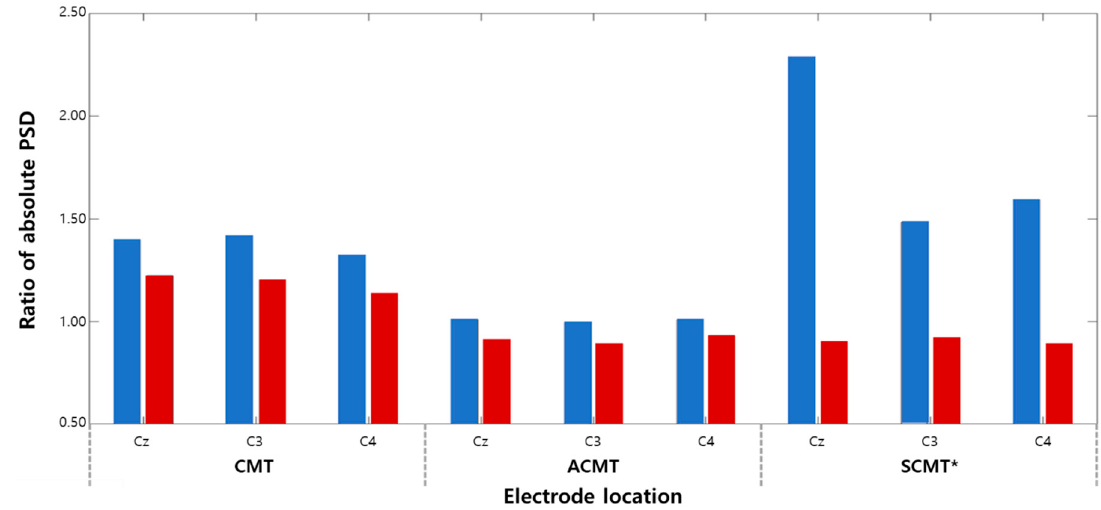
Figure 8. Absolute power spectral density (PSD) of the mu rhythm according to each rehabilitation protocol; blue: after first session, red: after last session (* p < 0.05).